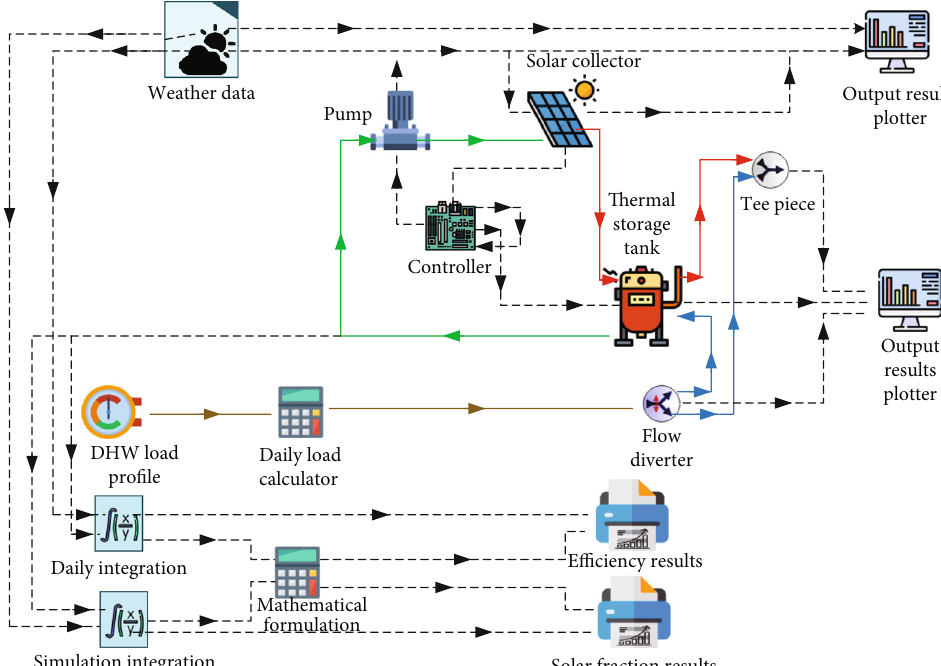
Figure 6: Component diagram of proposed SWH system in TRNSYS.